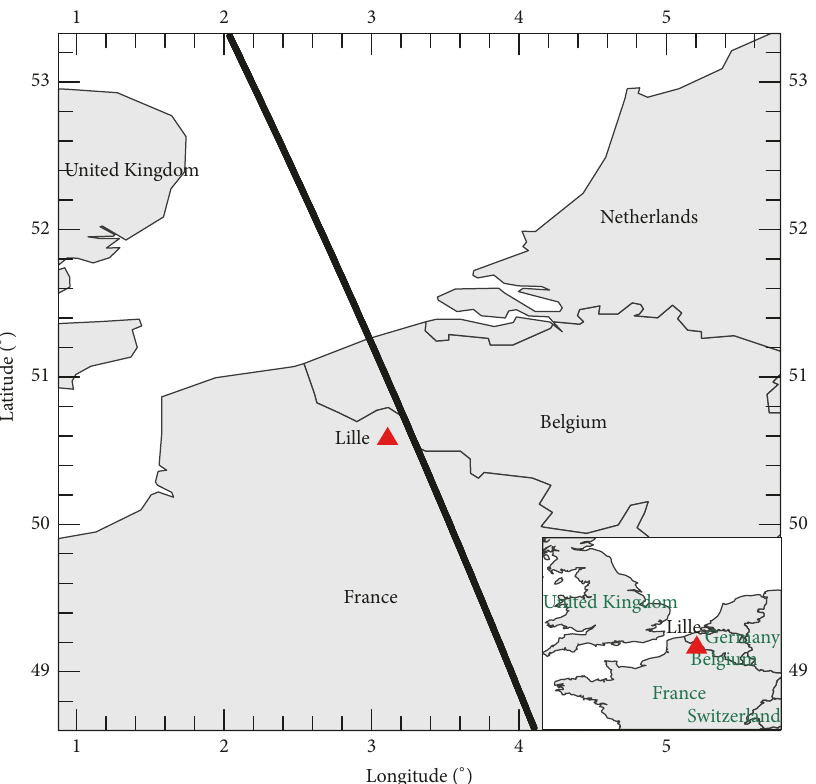
Figure 1: Location of the Lille Lidar site; the black solid lines signify the footprints of CALIPSO orbit. The closest distance between CALIOP footprints and the Lille Lidar site is 14.94 km, which was acquired at 12:50 UTC (daytime), February 27,